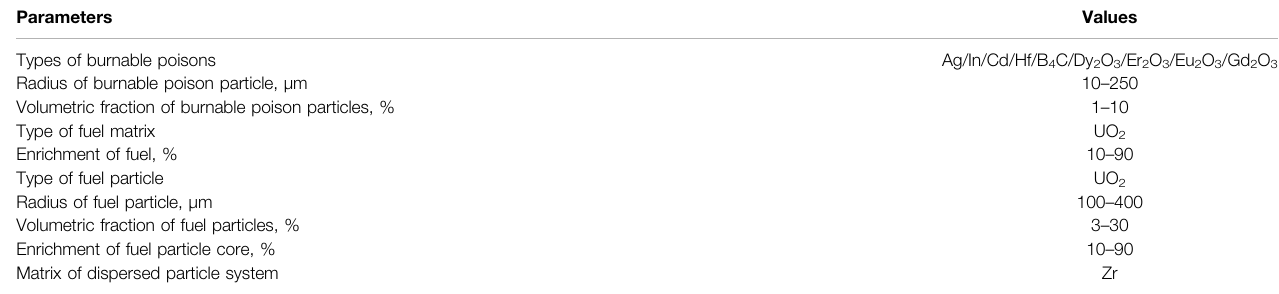
TABLE 2 | Parameters of particle-dispersed fuel and burnable